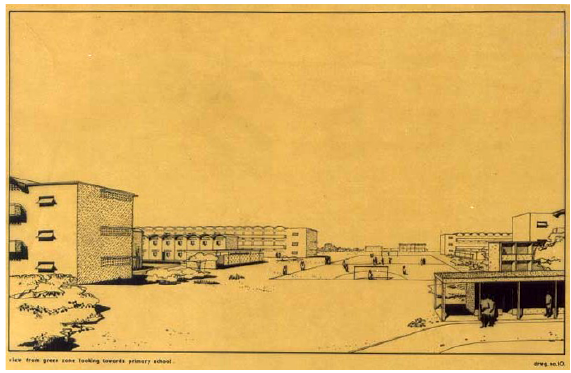
Figure 17. View from the green zone, Satellite Port Tudor. Source: Herrel